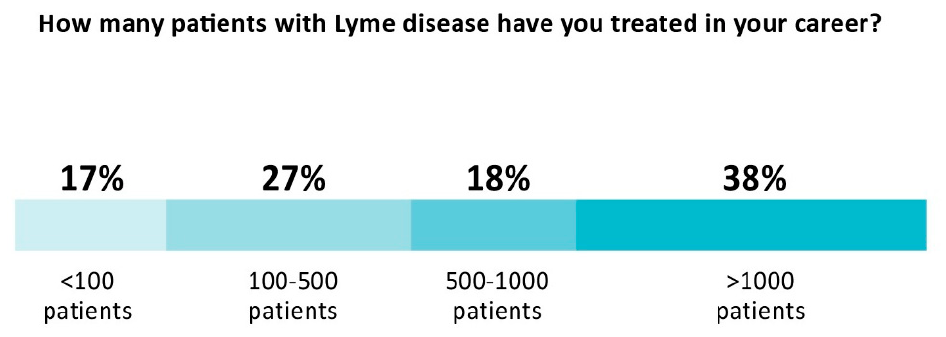
Figure 1. Clinician experience treating patients with PLD/CLD .